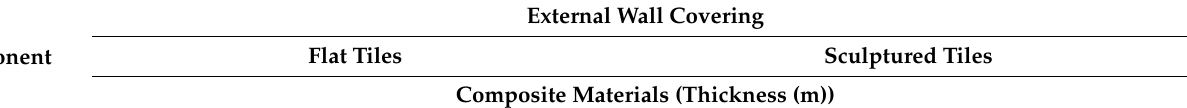
Table 3. Building components with composite